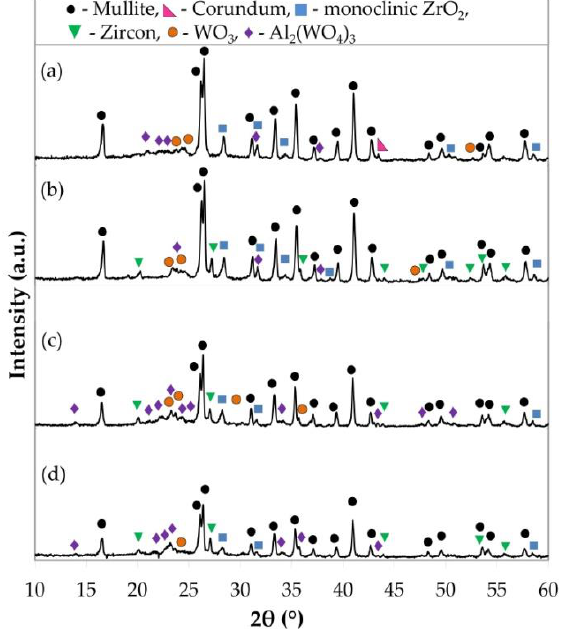
Figure 2. X-ray diffraction data of the sintered porous ceramic materials: ( a ) with YSZ:WO 3 (1:1), ( b ) with MSZ:WO 3 (1:1), ( c ) with YSZ:WO 3 (1:2) and ( d ) with MSZ:WO 3 (1:2).